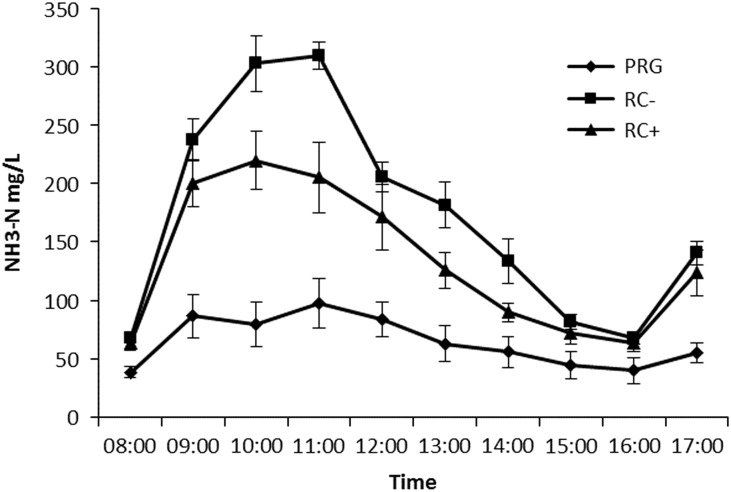
Temporal rumen ammonia-N (NH3-N) concentrations in steers offered the three experimental silages in experiment 1. PPO=polyphenol oxidase; RC+=high PPO red clover silage; RC−=low PPO red clover silage; PRG=perennial ryegrass silage.